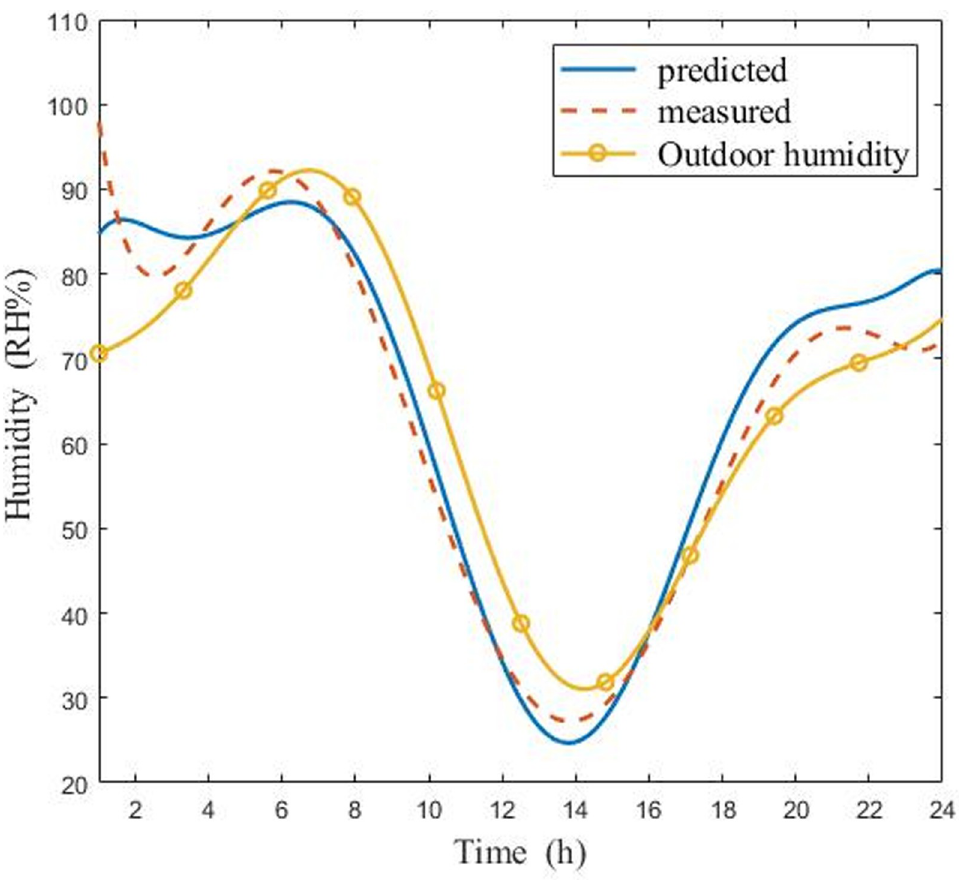
Fig 11. Comparisons of measured and predicted air humidity in CSG in sunny day (6:00 in the morning ~ 5:00 the next day).